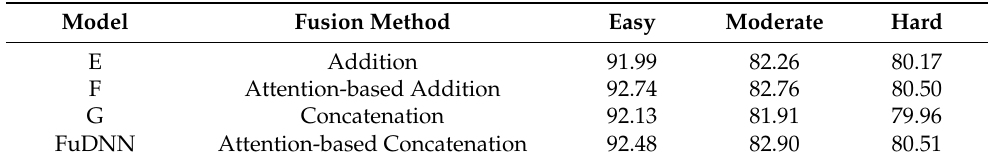
Table 5. Ablation experiments of different fusion methods in the car class of KITTI validation set with IoU threshold